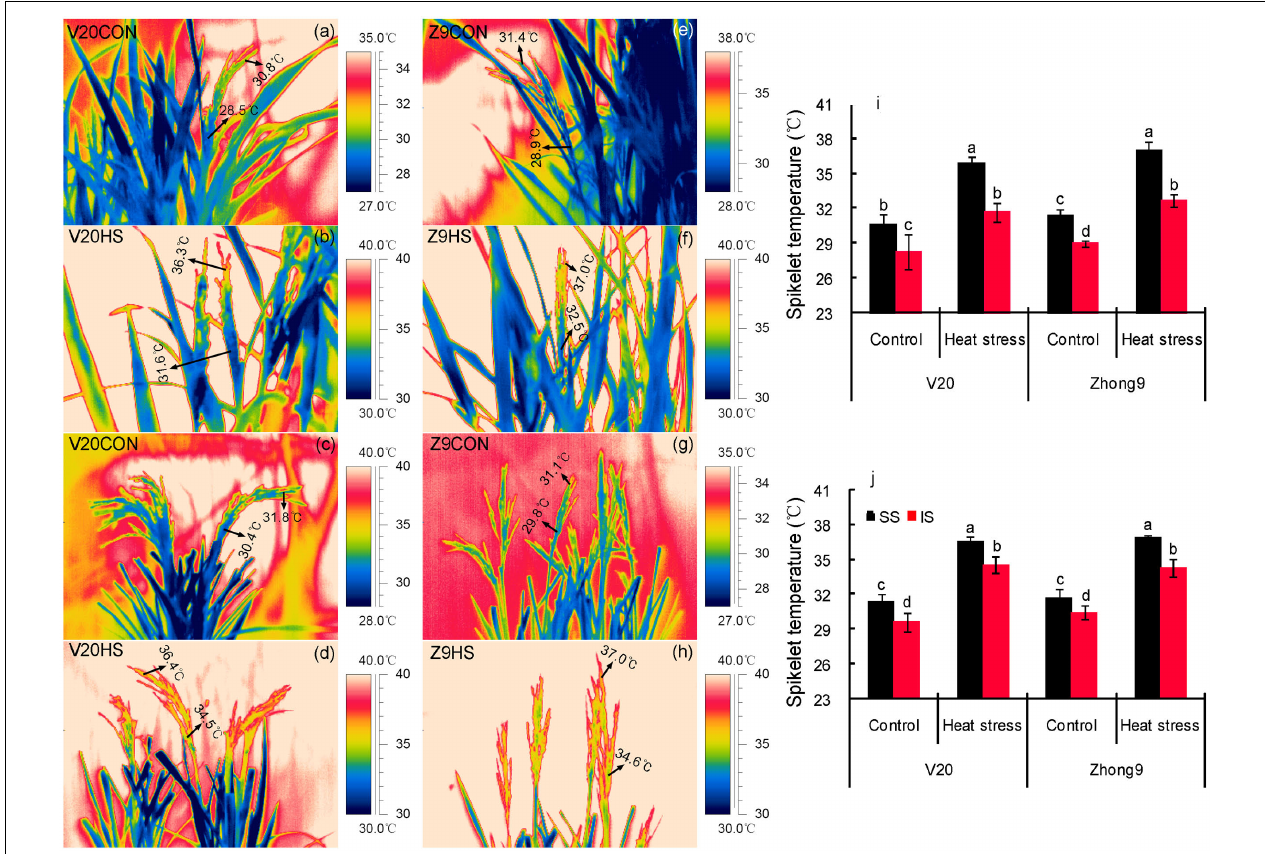
FIGURE 4 | Thermal images of superior and inferior spikelets with (a–d,i) or without (e–h,j) leaves. These thermal images were photographed on day 4 after heat stress of 40 ◦ C at 10:00 am–11:00 am, avoiding exposing direct sunlight. V20CON and Zhong9CON present genotypes V20 and Zhong9 under control condition, while V20HS and Zhong9HS present V20 and Zhong9 under heat stress. SS and IS were indicated as superior spikelets and inferior spikelets, respectively. The data in the figures (i,j) were shown as the mean of 10 replicates. Vertical bars denote standard deviations ( n = 10). Different letters indicate significant differences between the superior spikelets and inferior spikelets in the same cultivar ( P <